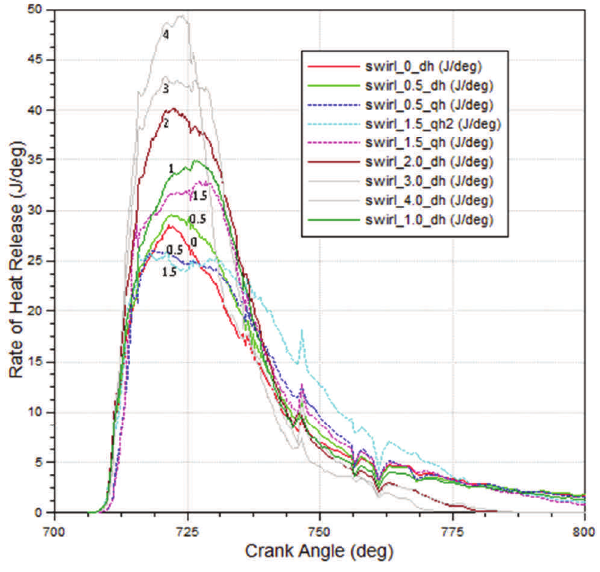
Fig. 6. Rate of heat release in respect to the crank angle for different swirl ratios